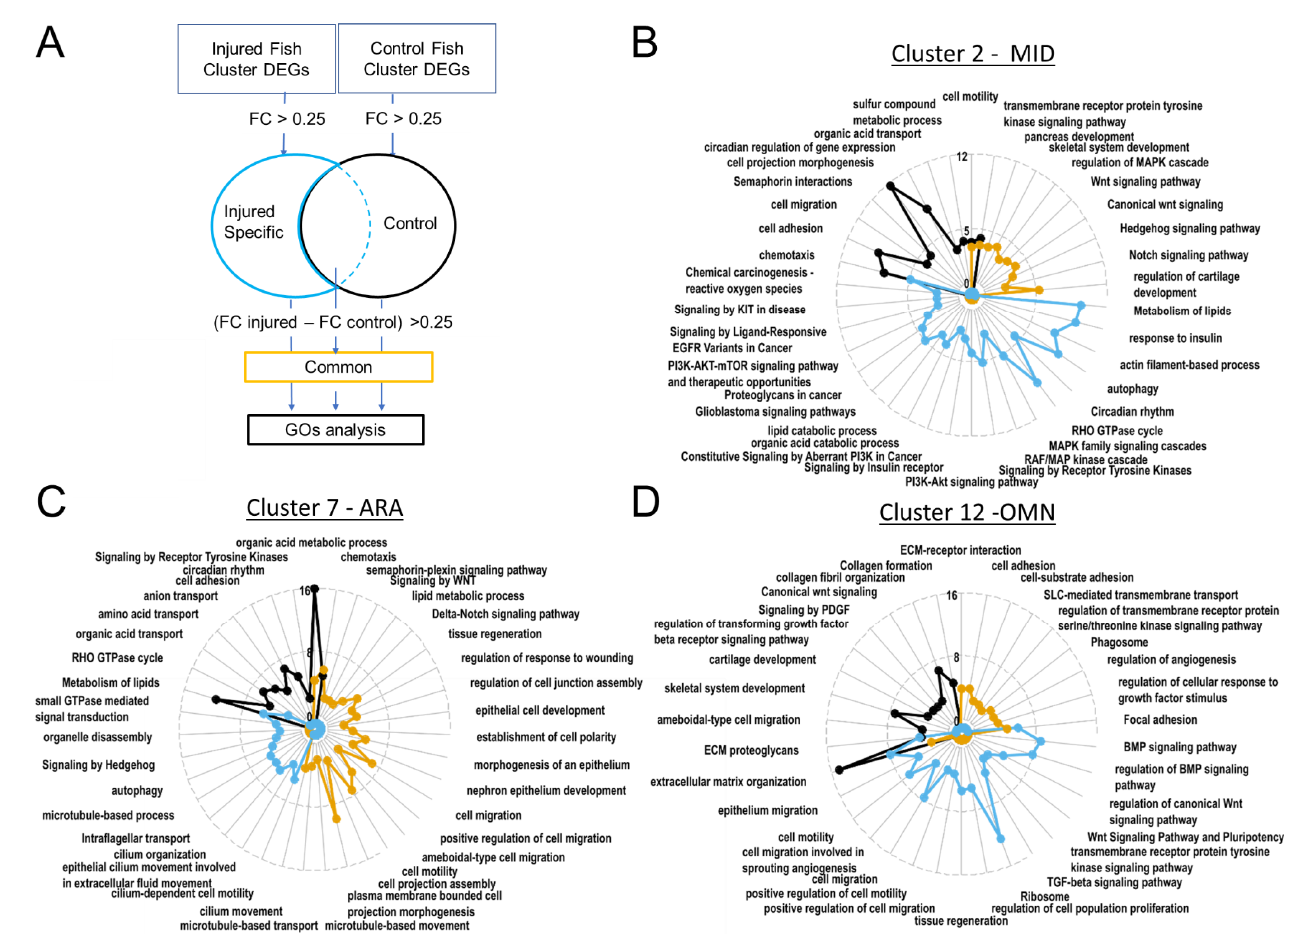
Figure 7. Gene ontology revealed upregulated biological processes. In ARA gene lists corresponding to genes specifically present in samples from injured fish, cilium-dependent cell motility GO and other cilium associated GOs are enriched. ( A ). Pipeline for filtering DEGs for GO analyses with Metascape. Radarplots of enriched Gene ontologies. Curves colored following types of filtering as explained in ( A ). Axis concern Zscore of GOs. Increased distance from the centre means higher significance. ( B ). OMN. ( C ). MID. ( D ).